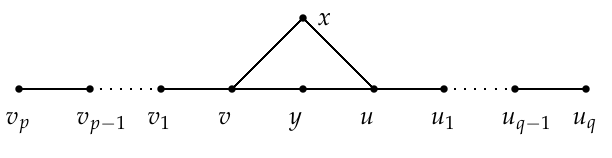
Figure 2. Graph H in Lemmas 8 and